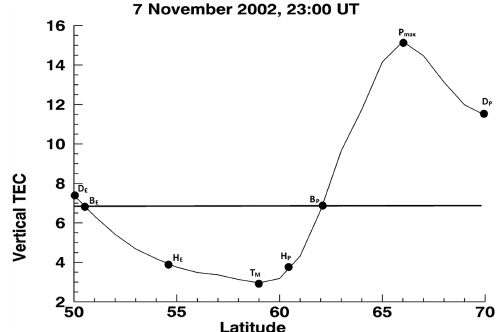
Figure 2. Example plot, for 23:00UT on 7 November 2002, of VTEC (in TECU) at a longitude of 0.0 ◦ E for the EDAM elec- tron density grid as a function of latitude (in degrees). It illustrates the set of parameters used to characterize the location and shape of the main ionization trough. The horizontal line shows the aver- age TEC over the latitudinal profile, and breakpoints are identified where this average level intersects the profile. The trough is char- acterized by the following parameters: the trough minimum ( T M ) , equatorward extreme ( D E ) , poleward extreme ( D P ) , equatorward breakpoint ( B E ) , poleward breakpoint ( B P ) , equatorward half point ( H E ) , the poleward half point ( H P ) and the poleward maximum ( P max ) . The half points are used to characterize the shape of the trough in the vicinity of the trough